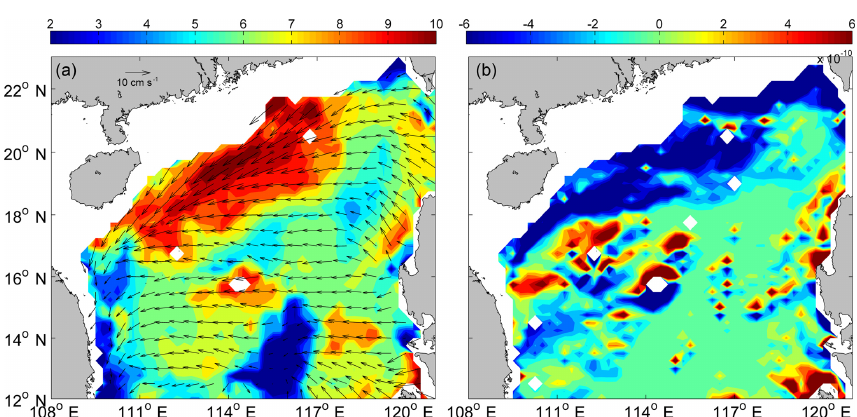
Figure 3. (a) Annual mean of eddy propagation speed directions (vectors) and magnitudes (color, cms − 1 ). (b) Meridional distribution of the topographic β effect (color shading).